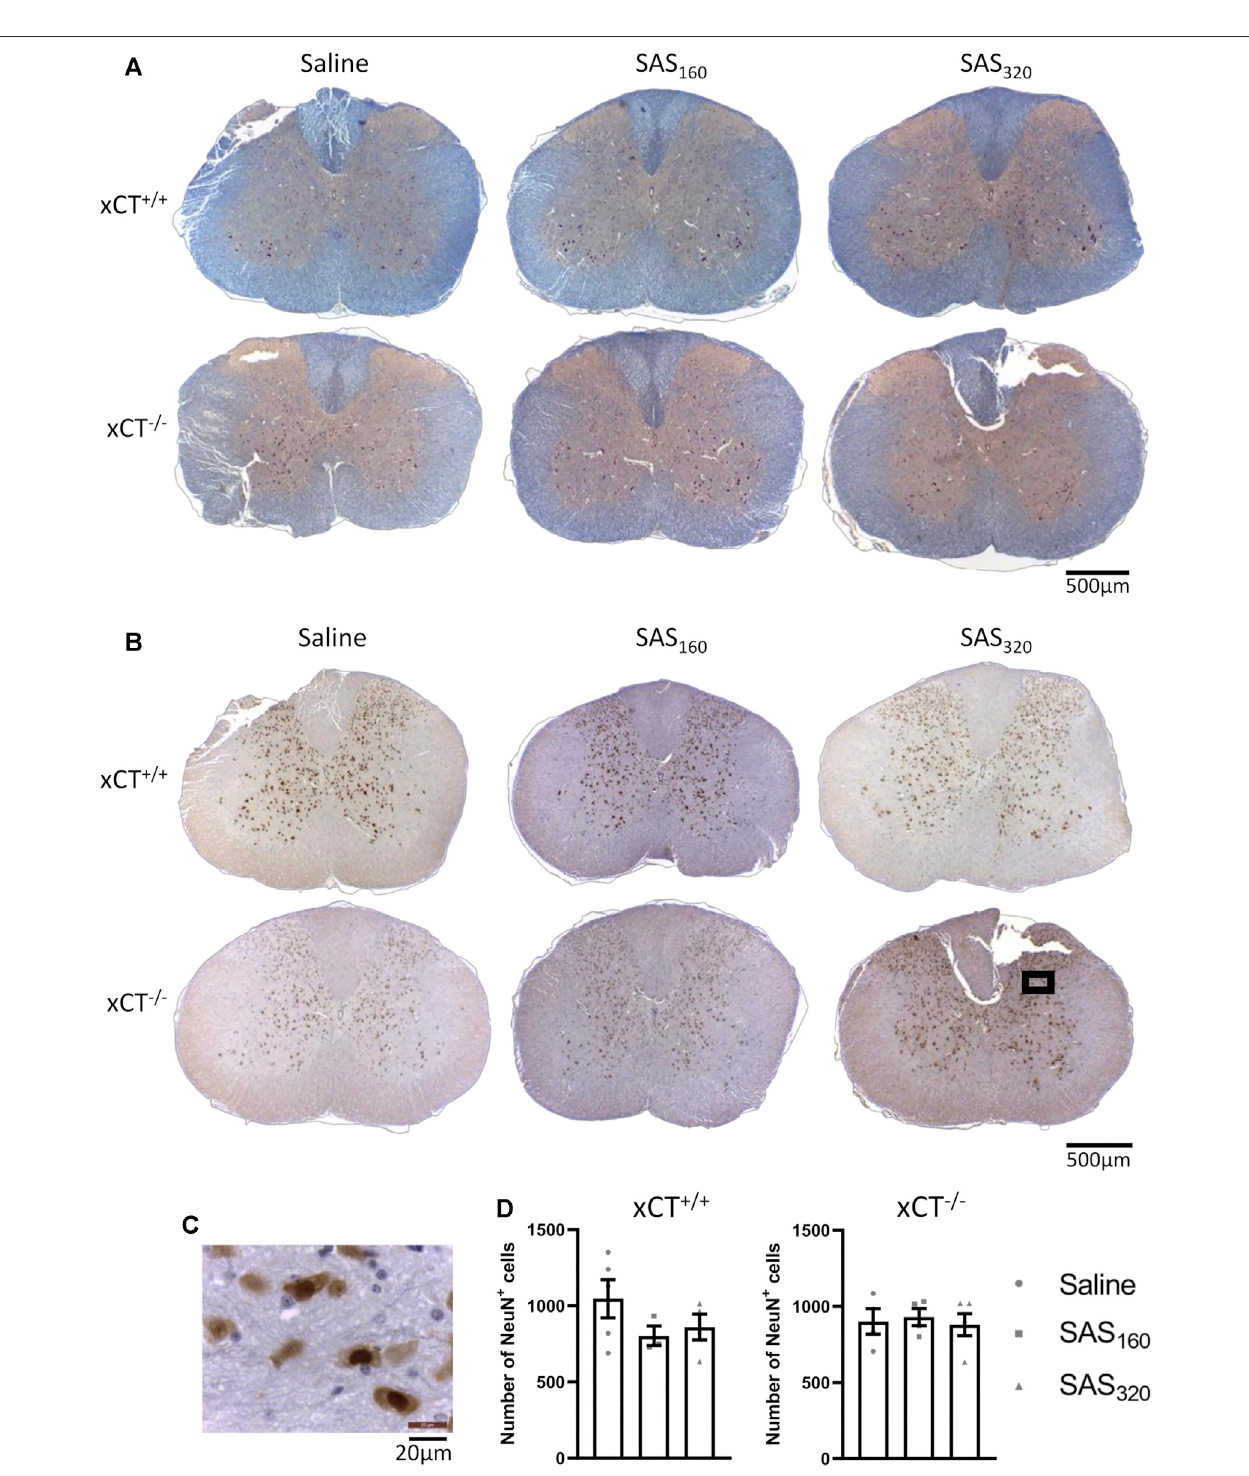
FIGURE 6 | Histological examination of the spinal cord of mice after chronic sulfasalazine (SAS) treatment. Representative photomicrographs of the eriochrome cyanine/neutral red staining (A) as well as the NeuN immunohistochemistry (B) . A higher magni fi cation picture of the boxed area in (B) is shown in (C) . NeuN + cells were quanti fi ed using the Cell Sens software (D) . One slice of n (cid:2) 3 – 5 mice/group was used, data are presented as mean ± SEM and analyzed using a Kruskal-Wallis test followed by Dunn ’ s multiple comparisons for each dose of SAS compared to saline.